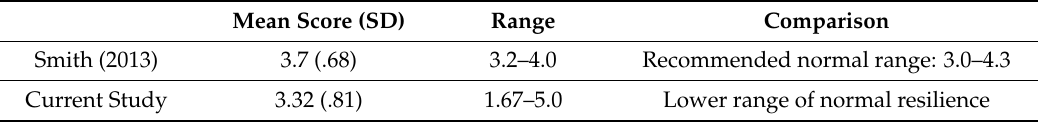
Table 2. Brief resilience scale